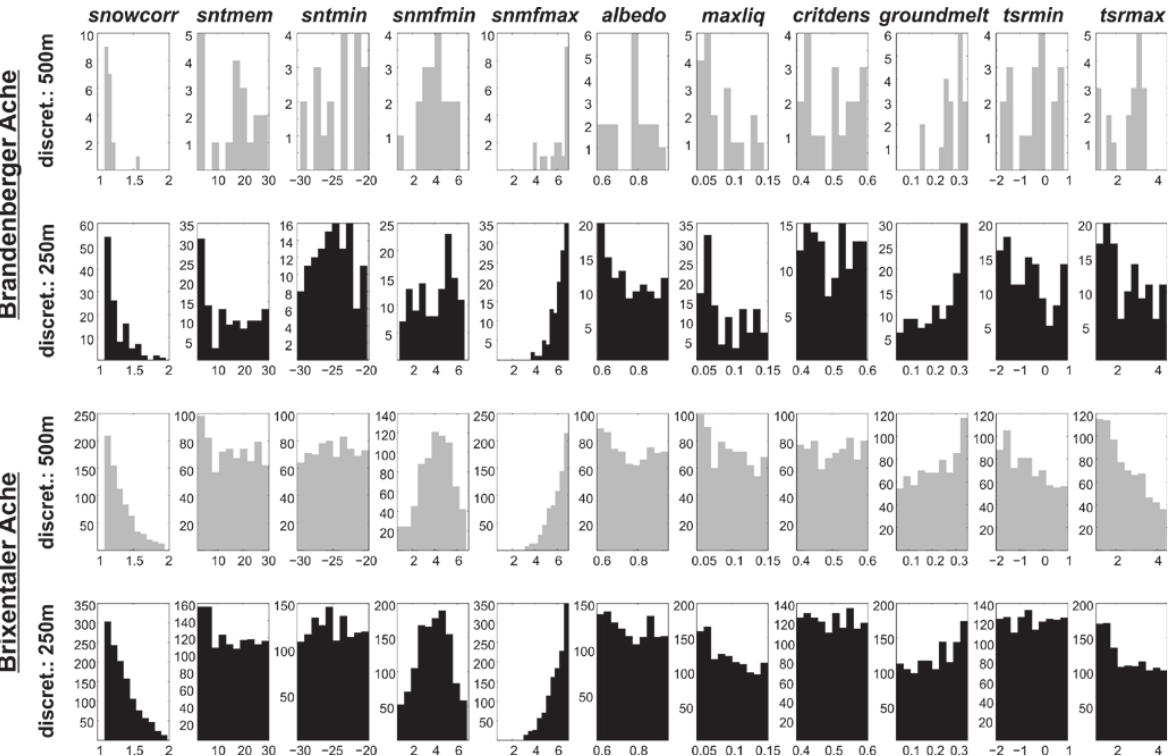
Fig. 3. Histograms of the distribution of the Pareto optimal parameter settings. A description of the parameters can be found in Sect. 2.2.